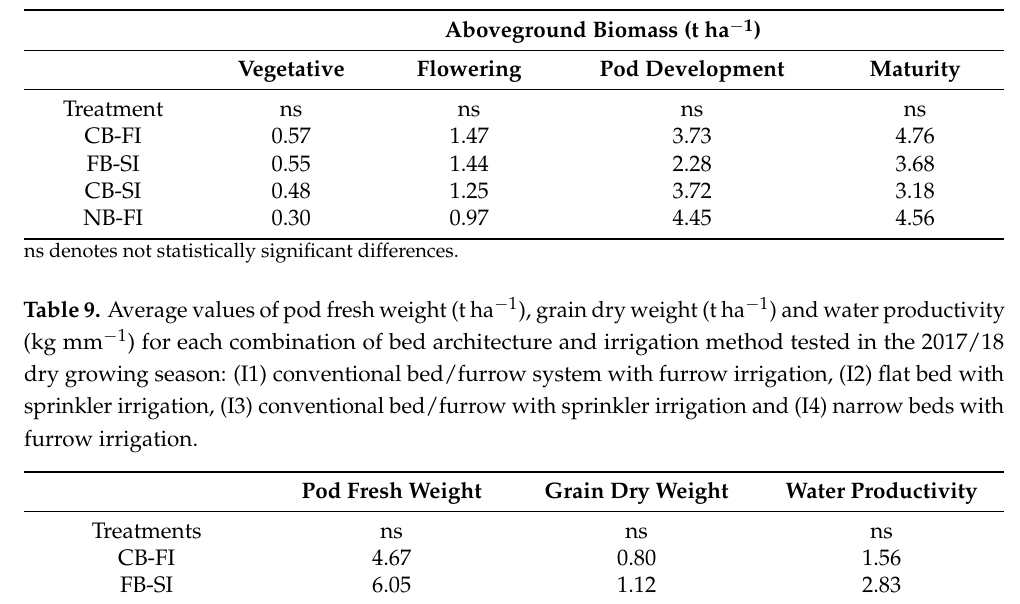
ns denotes not statistically significant differences.